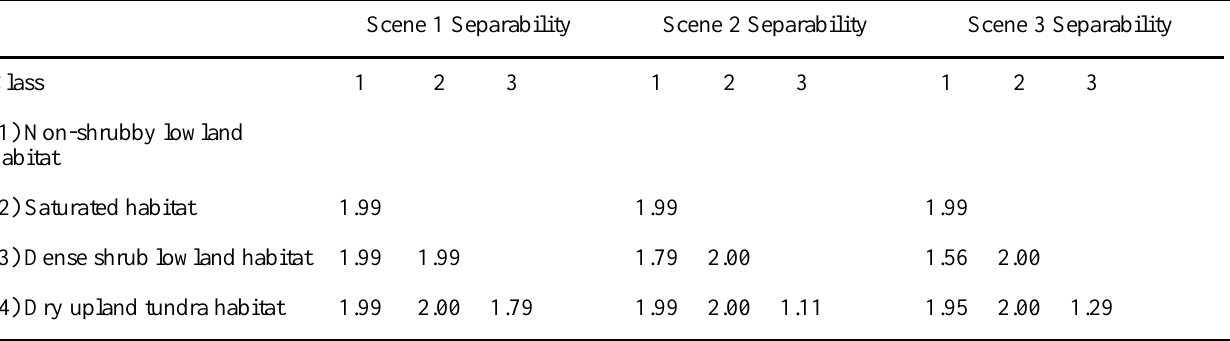
Table 3. Signature separability between land-cover classes used in the supervised classification. Values are calculated as the statistical difference between parts of spectral signatures using Bhattacharrya Distance methods. A value of 0 indicates a complete overlap in the spectral signature between the two classes and a value of 2 indicates complete separation. Habitat type numbers across the top match those on the